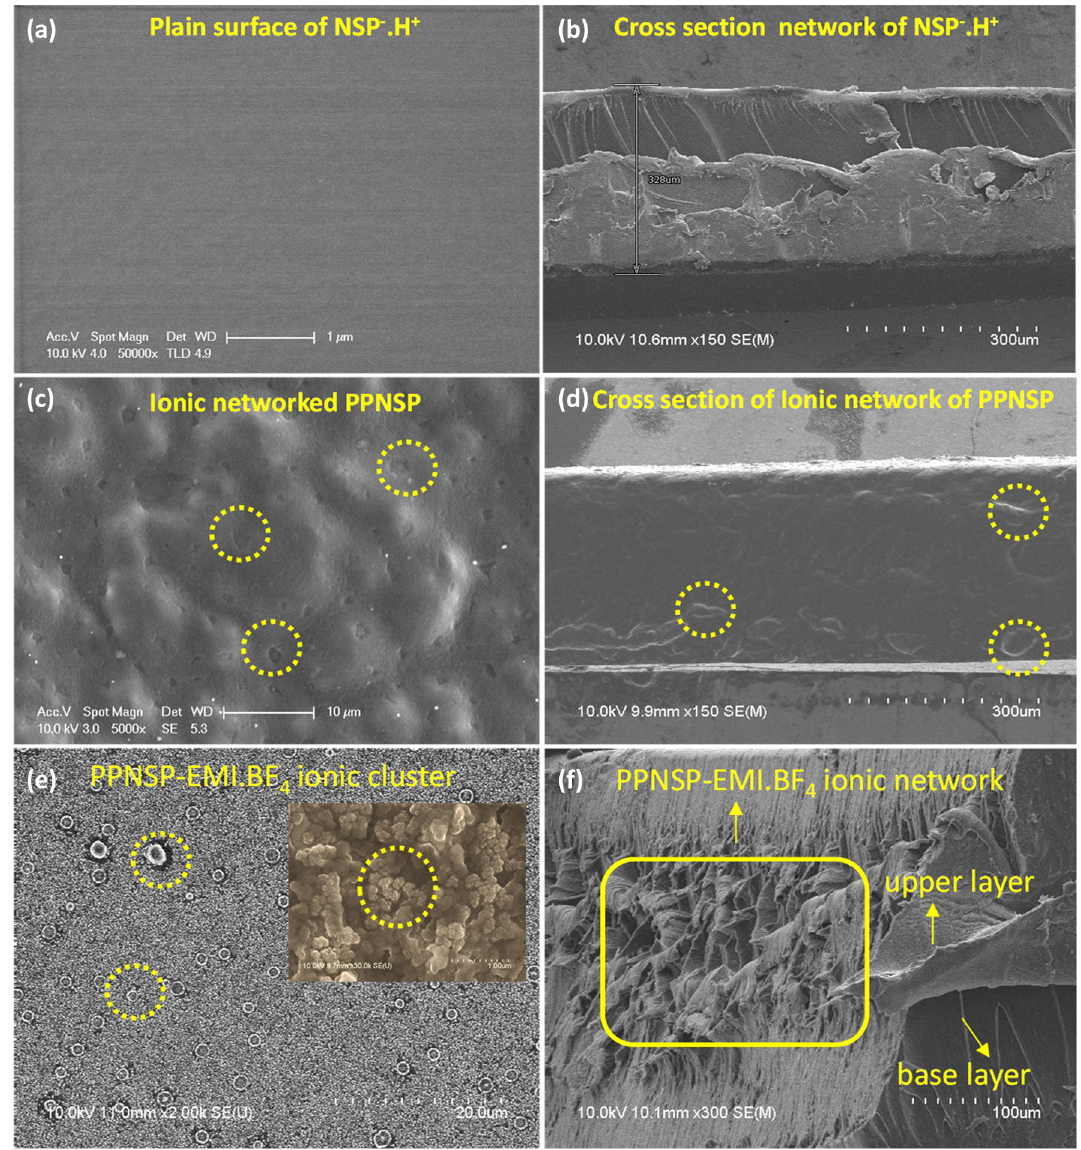
Figure 4. FE-SEM images of the surface morphologies of NSP.H + , PPNSP, and PPNSP-EMI.BF 4 composite films; ( a , b ) regular plain surface; ionic networked submicron to micron hallow grooves and knots on the surface, ( c , d ); ionic clusters on the surface of PPNSP film by aggregations of EMI.BF 4, (inset image, strongly glued PPNSP-EMI.BF 4 ionic clusters, which can help to promote the ion hopping mechanism, at 1 μm magnification) ( e ), and loosely bonded ionic networks in the cross-sectional view of PPNSP-EMI.BF 4 composite film ( f Fig. 6e and f. In specific, it can be seen that the PPNSP-EMI.BF 4 -PTFE TENG showed higher electrical output than the other two systems (i.e., NSP.H + -PTFE, and PPNSP-PTFE TENG) owing to the availability of abundant mobile BF 4− ions from EMI.BF 4 IL. The present result have been justified the concept by the Jang et al. have dis- played higher conductivity through our PPNSP-EMI.BF 4 e-skin TENG in comparison with NSP.H + and PPNSP TENGs due to the addition of EMI.BF 446 .